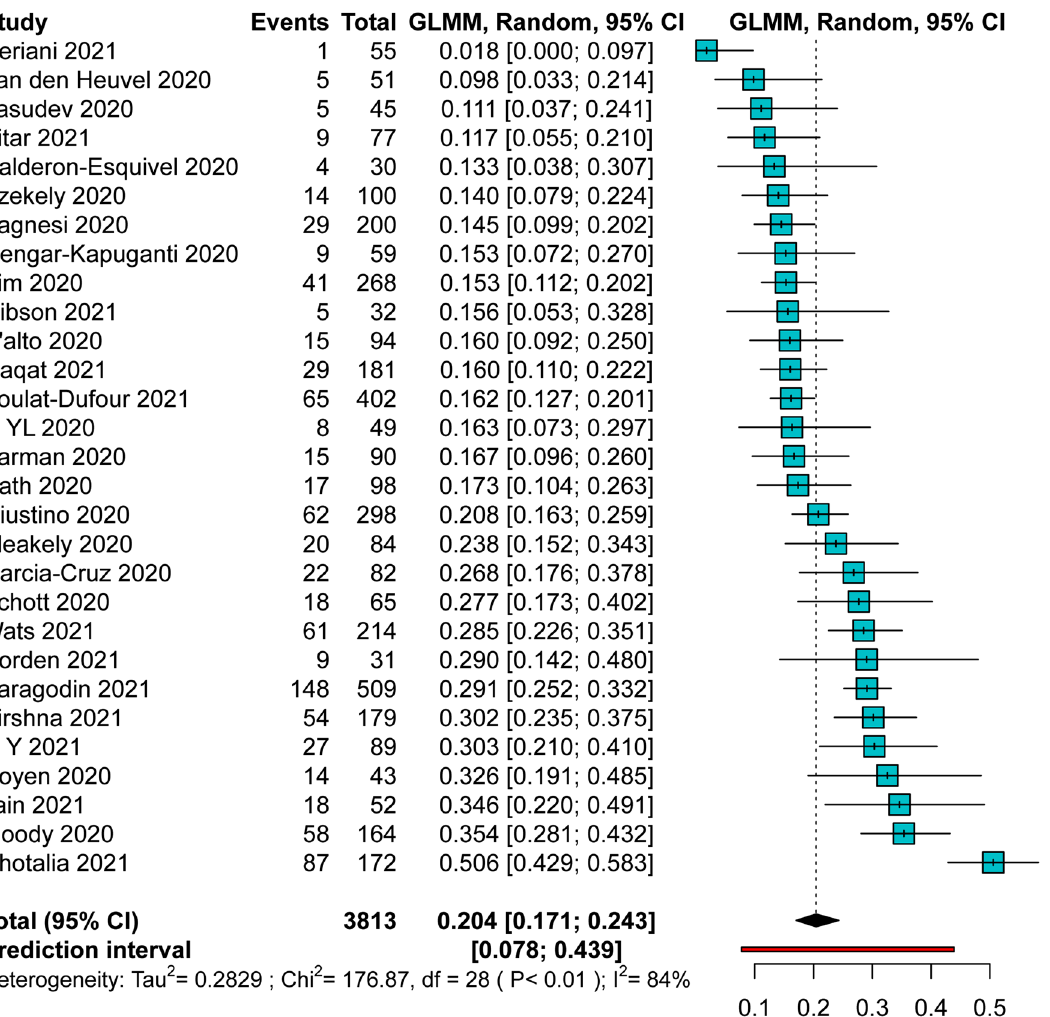
Figure 1. Pooled Prevalence of RVD among patients with COVID-19. CI confidence intervals, GLMM generalized linear mixed